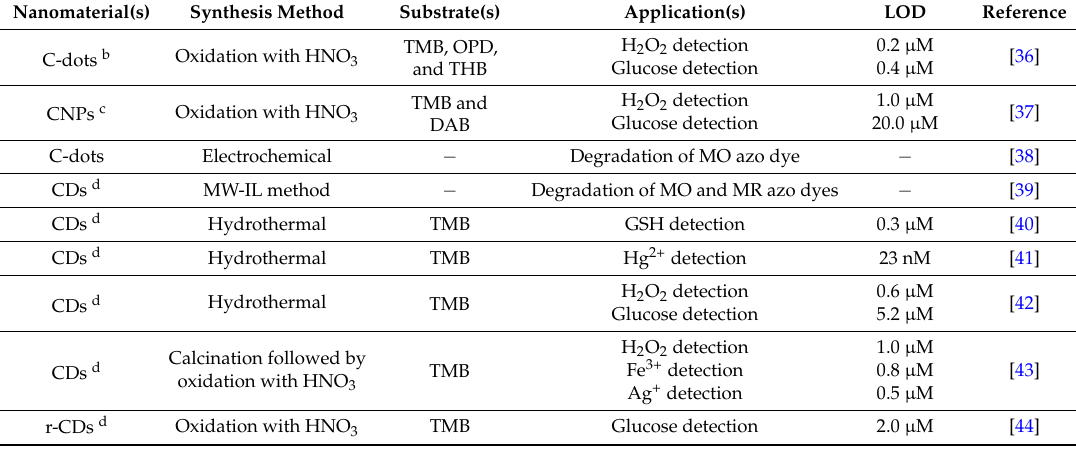
Table 1. POD-like activity of carbon nanodots.